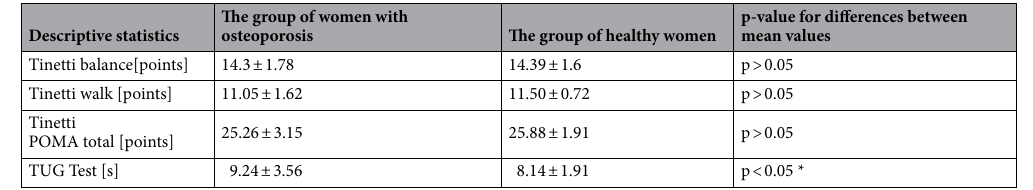
Table 7. Tinetti POMA test & TUG results. ( * p < 0.05).